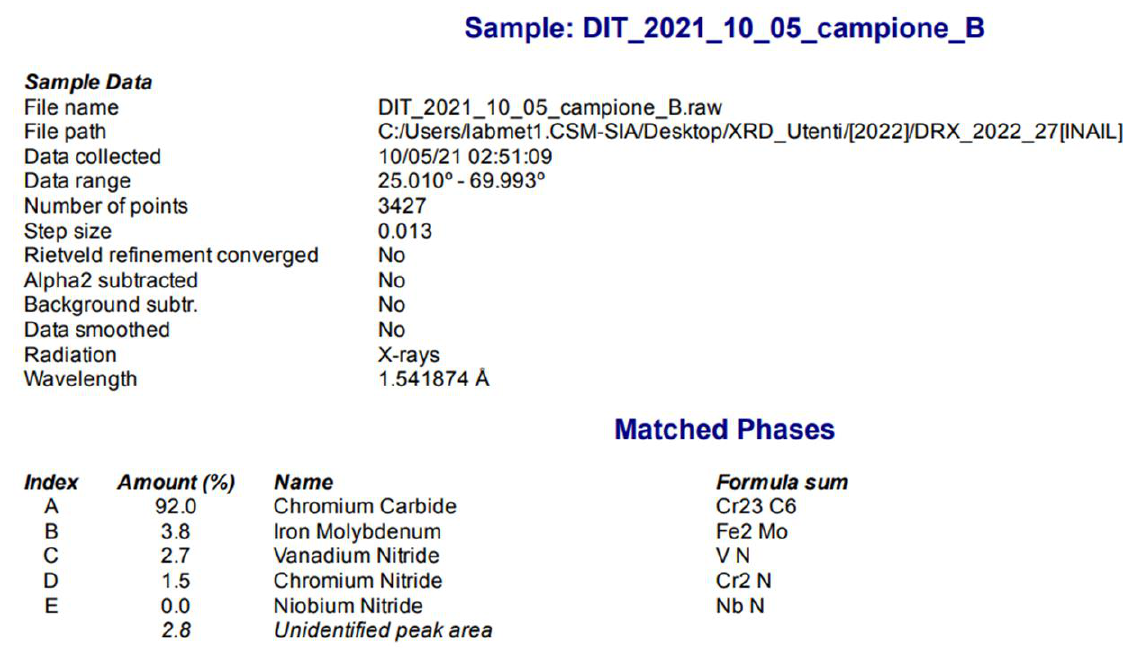
Figure A1. Failed crept cross-weld specimen 91-HAZ-3-5 600 °C 112 MPa 3216 h (sample B). XRD analysis.